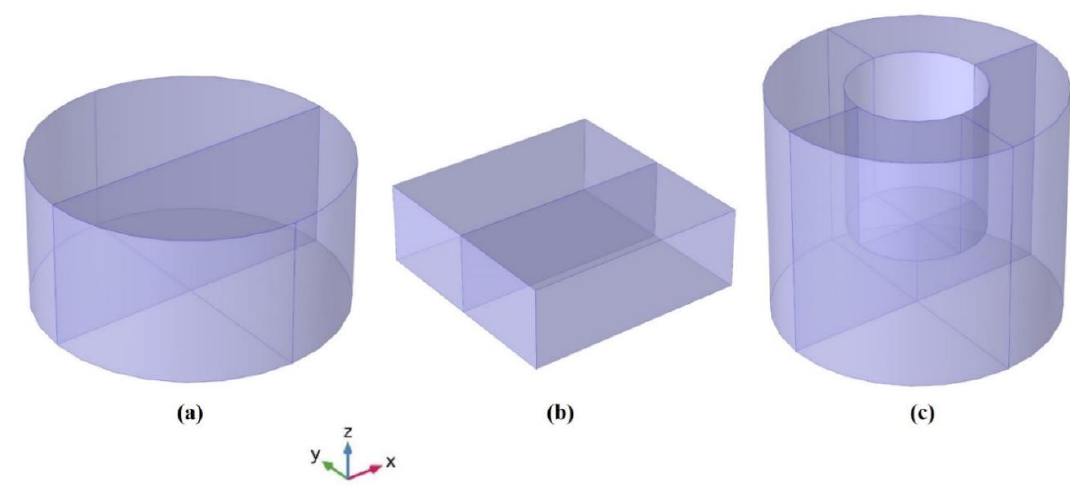
Figure 2. Composite samples used for drying experiment: ( a ) cylindrical, ( b ) rectangular, ( c ) hollow cylinder with closed end.